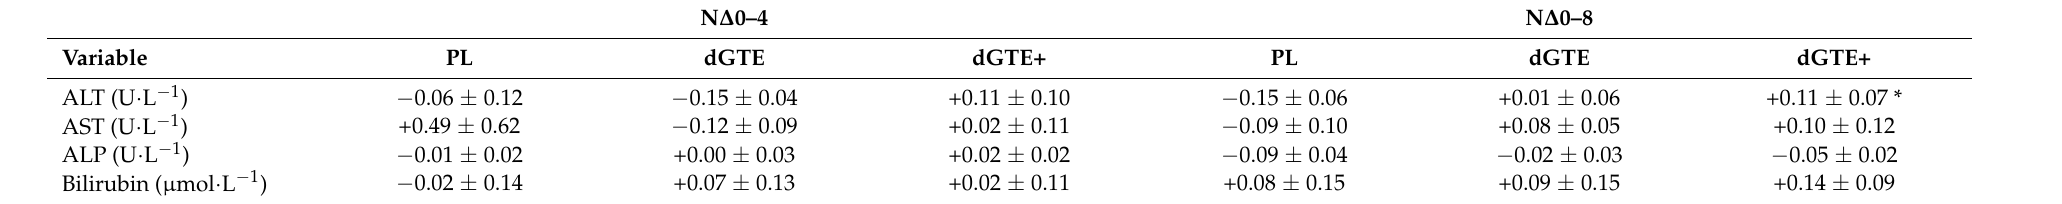
Table 10. Normalised mean fold change in serum liver function markers by week 4 (N ∆ 0–4), and week 8 (N ∆